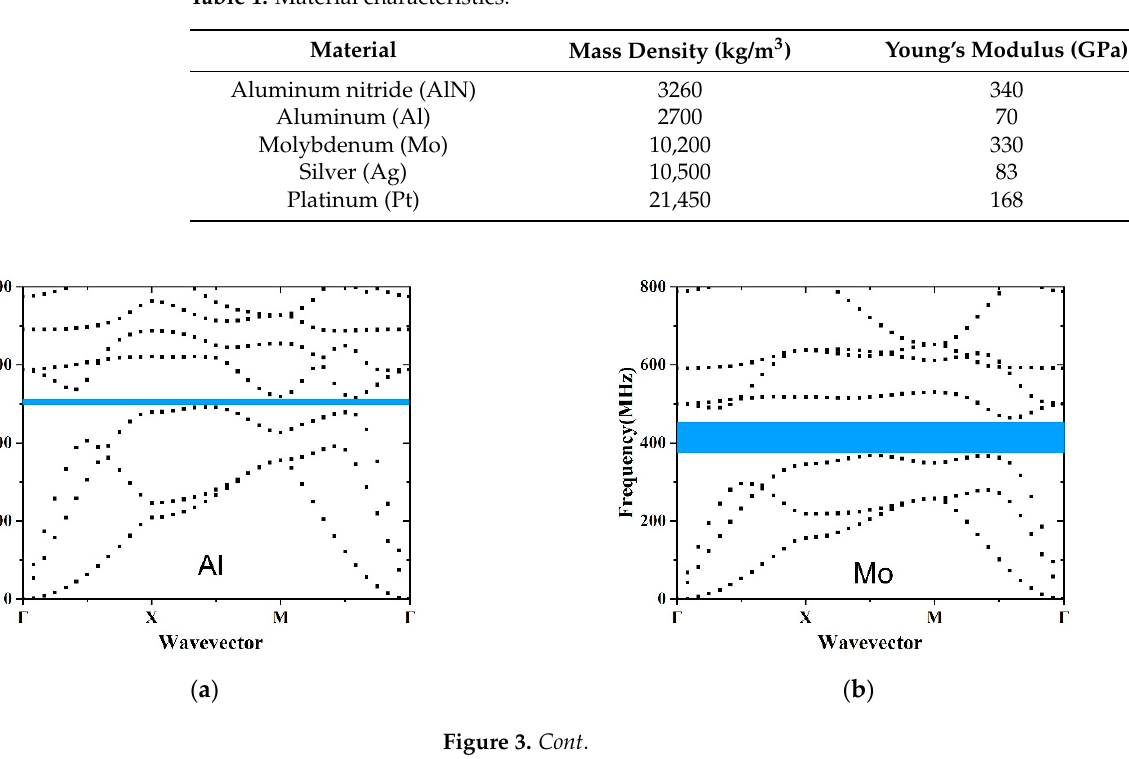
Table 1. Material characteristics.